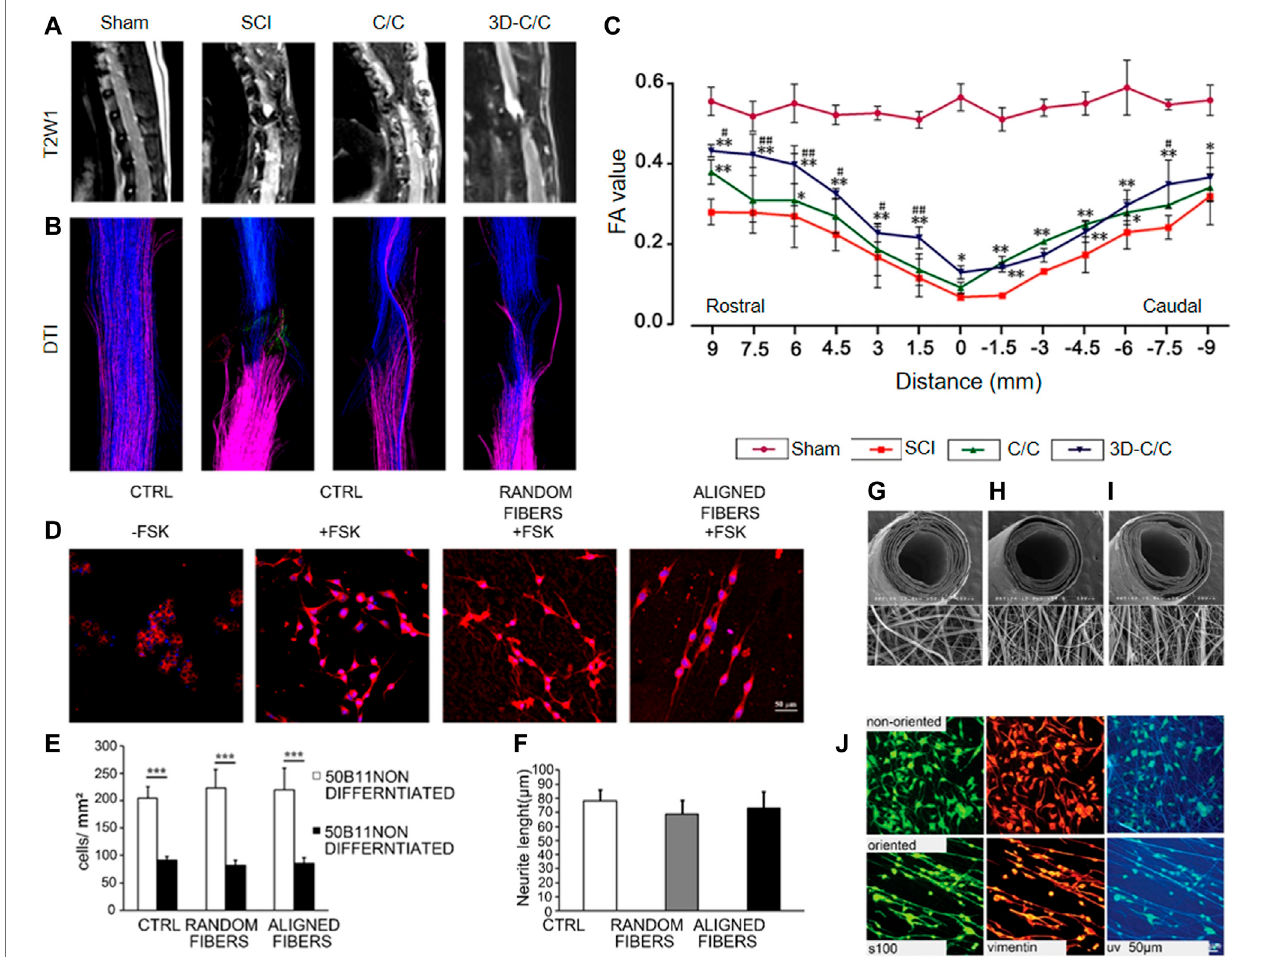
FIGURE 3 | MRI-DTI estimating the recovery of white matter fi ber after SCI. (A) : T2W1 micrograph of the conventional sagittal spinal cord. (B) : DTI-tracked white matter fi bersofspinal. (C) :Therelationshipoffractionalanisotropy (FA)valueanddistance(mm).C/C: collagen/chitosanscaffoldwithfreezedryingtechnology.3D-C/C: collagen/chitosan scaffold with 3D printing technology. * p < 0.05, ** p < 0.01 versus SCI group. # p < 0.05, ## p < 0.01 versus C/C group. Reproduced with permission (Sun et al., 2019). 2019, Wiley. (D) Confocal micrographs of B5011 cells stained by DAPI (blue) and β -tubulin (red) 24 h after different treatments. (E) Comparative 50B11 cell number of different treatment groups. (F) Comparative Neurite length of different treatment groups. FSK: forskolin; *** p ≤ 0.001; Scale bar: 50 μ m. Reproduced with permission (Gnavi et al., 2015). Copyright 2015, MDPI. (G) SEM images of electrospun, non-oriented chitosan nano fi ber mesh tube. (H) SEM images of electrospun, oriented chitosan nano fi ber mesh tube. (I) SEM images of electrospun, bilayered chitosan nano fi ber mesh tube. (J) Immunocytochemistry of the immortalized Schwann cell line, IMS32, after culture for 4 days on the nonoriented (upper) and oriented (lower) chitosan nano fi ber mesh sheet. Reproduced with permission (Wang et al., 2009). 2008,